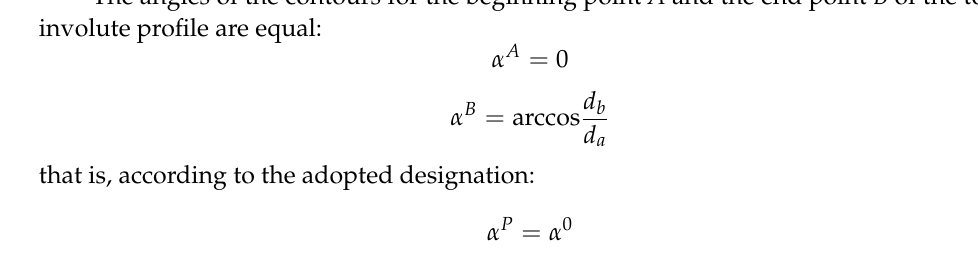
Figure 2. An involute outline of a machined